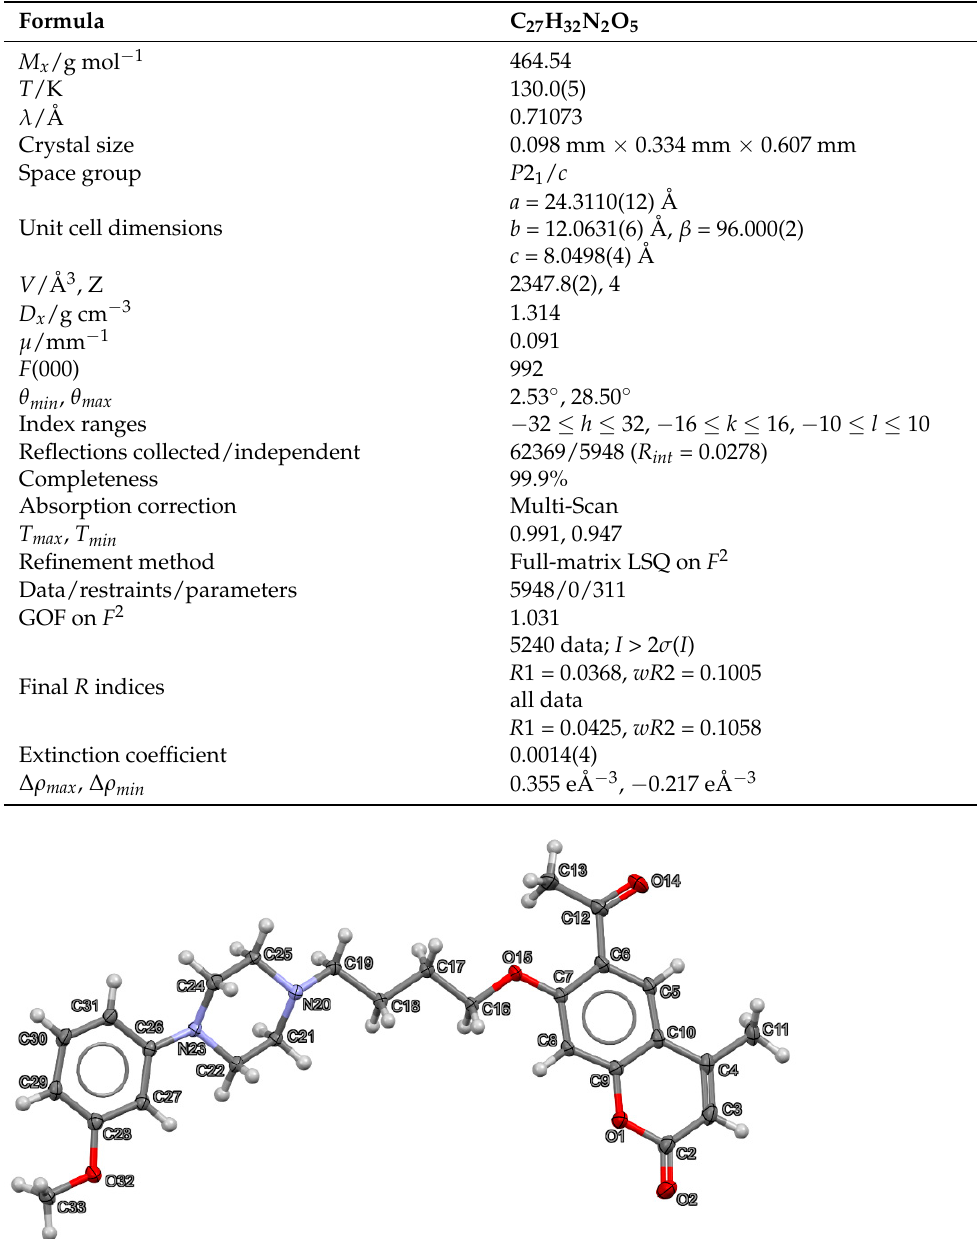
Table 1. Data collection and structure refinement parameters for 2 .